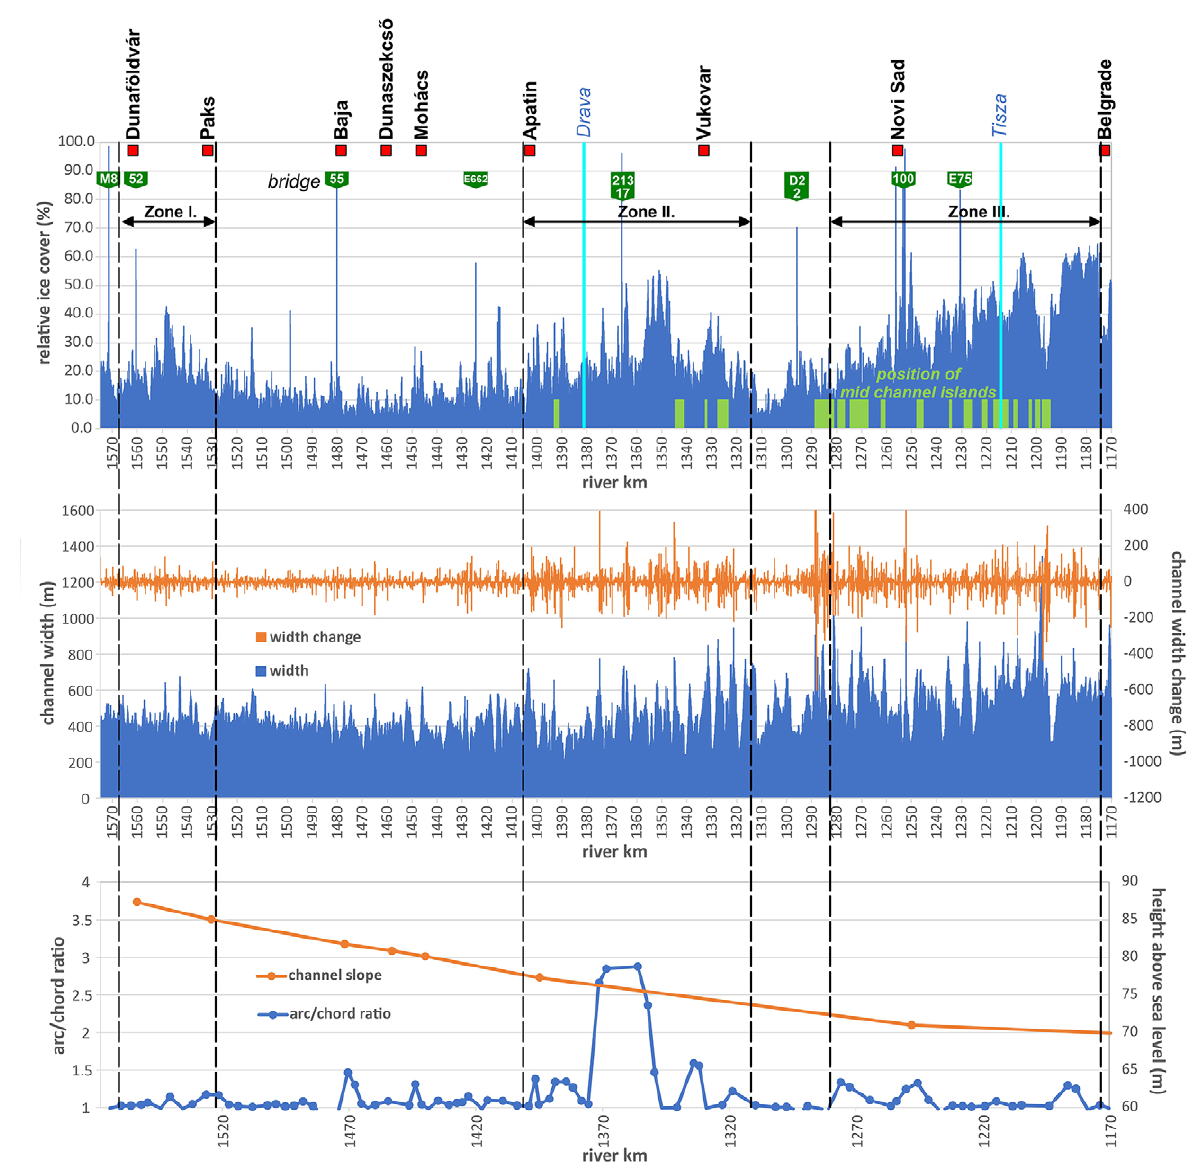
Figure 12. The time averaged distribution of ice cover on the investigated river reach, and the longitudinal change of channel geometric parameters (width, width change, meander arc/chord ratio, water surface slope at low water, position of